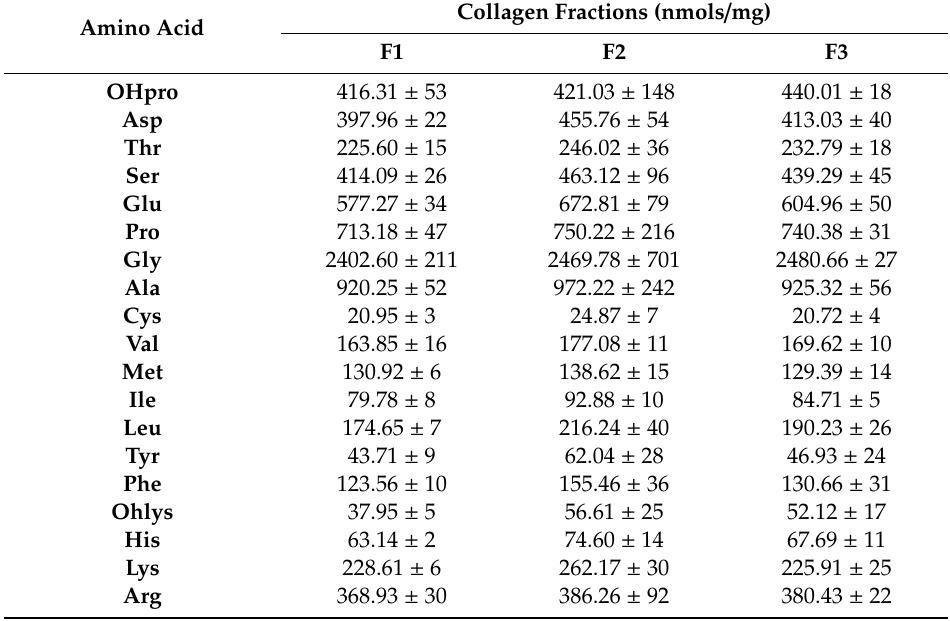
Table 1. Amino acid composition of three collagen fractions (F1, F2, and F3) obtained from the skin and bones of M. merluccius